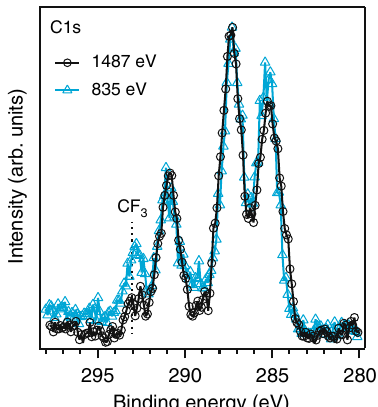
Fig. 3 Varying APPES probing depth on 1 M LiTFSI in PC electrolyte drop. C 1s spectra of Elect-Drop samples using two excitation energies showing the increased CF 3 intensity relative to the PC related intensity for higher surface sensitivity (i.e. 835 eV excitation energy). The intensities are normalized with respect to the C-O peak at 287